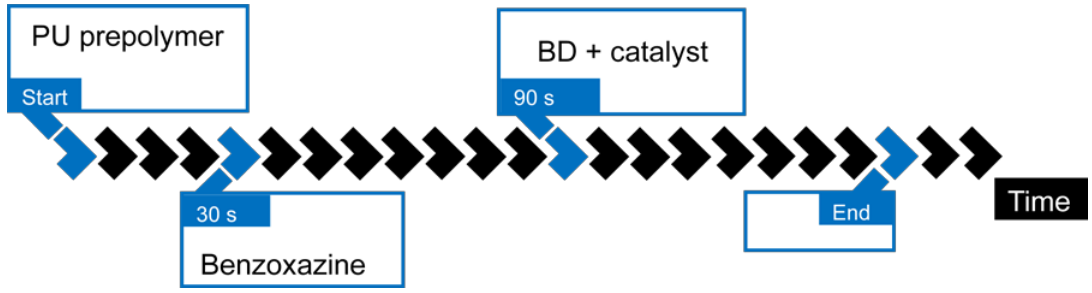
Figure 1. Timeline for preparation of Shape-Memory Polyurethanes (SMPU)-benzoxazine compounds. The set temperature of Brabender Mixer was respectively 80 °C and 90 °C for PU with amorphous and crystalline soft-segment.